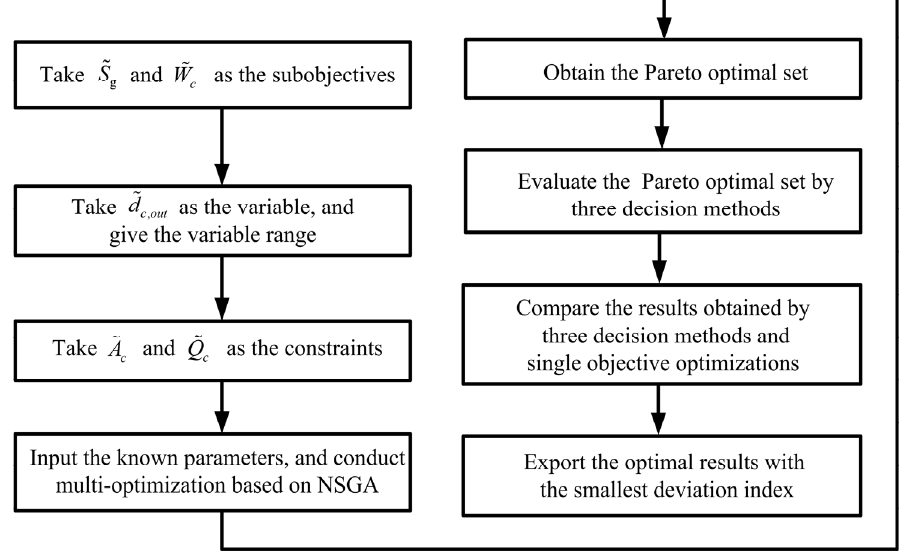
Figure 11. Flow chart of the multi ‐ objective optimization.